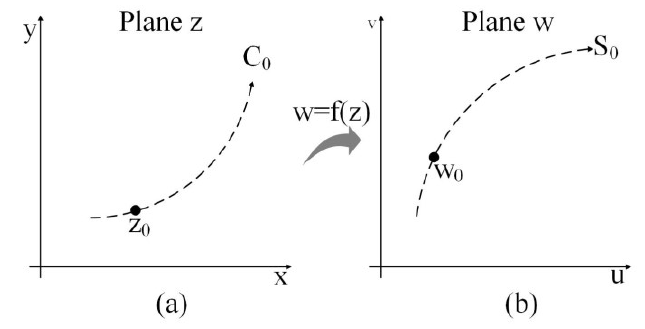
Fig. 4: Curve in z Plane and its Image in w Plane